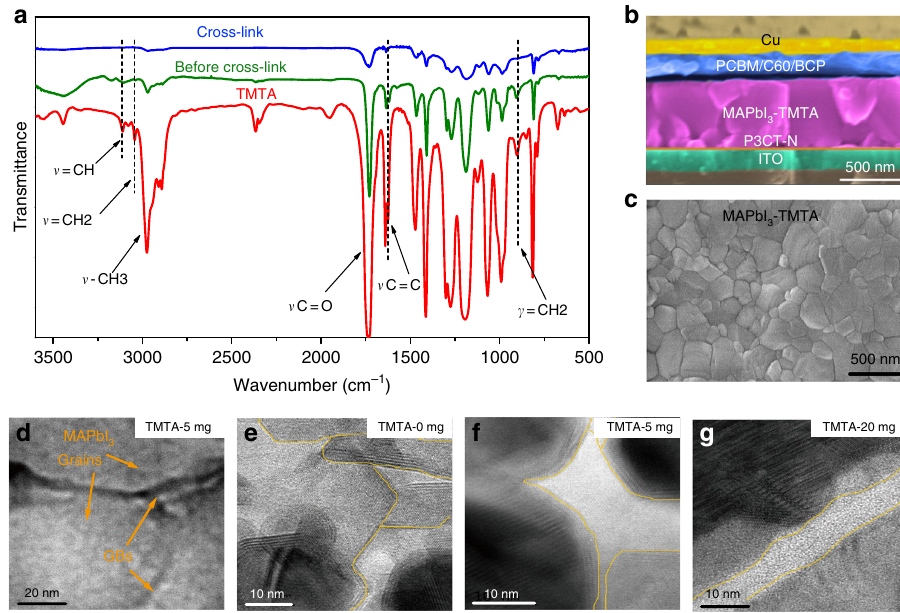
Fig. 2 FTIR and morphology characterization. a FTIR spectra of MAPbI 3 – TMTA fi lms before (olive), after (blue) cross-linking and pure TMTA (red). The dash lines indicate the characteristic vibration peaks of TMTA. b Devices structure and cross-section SEM images of inverted PSCs used in our work. c Top-view SEM images of MAPbI 3 – TMTA fi lms. d Low-magni fi cation TEM image of MAPbI 3 – TMTA fi lms. TMTA-5 mg indicates that the concentration of TMTA in MAPbI 3 precursor solution is 5 mg mL − 1 . e – g High resolution TEM of perovskite fi lms: ( e ) MAPbI 3 ; (f) MAPbI 3 – TMTA (5 mg mL − 1 ), and ( g ) MAPbI 3 – TMTA (20 mg mL − 1 ). The yellow lines demarcate the grain boundary (GB)